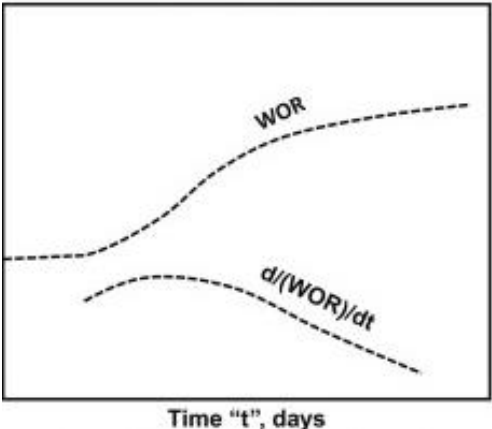
Figure 3. Bottomwater coning WOR and WOR’ derivates [ 5] .